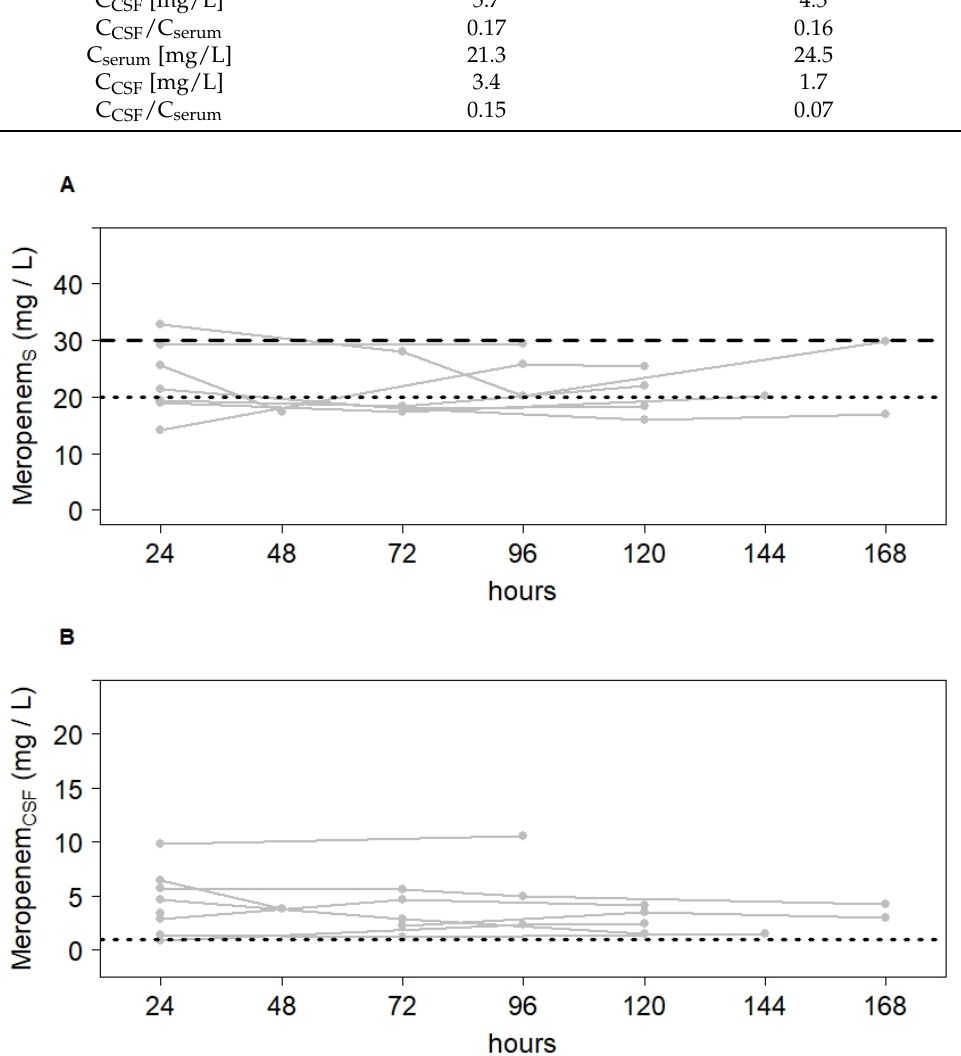
Figure 2. Variation of meropenem concentrations in serum ( A ) and CSF ( B ) over the first 7 days of treatment. Narrow lines depict the course of every individual patient (n = 9). The dotted line depicts the lower and the dashed line the upper limit of the target concentration.